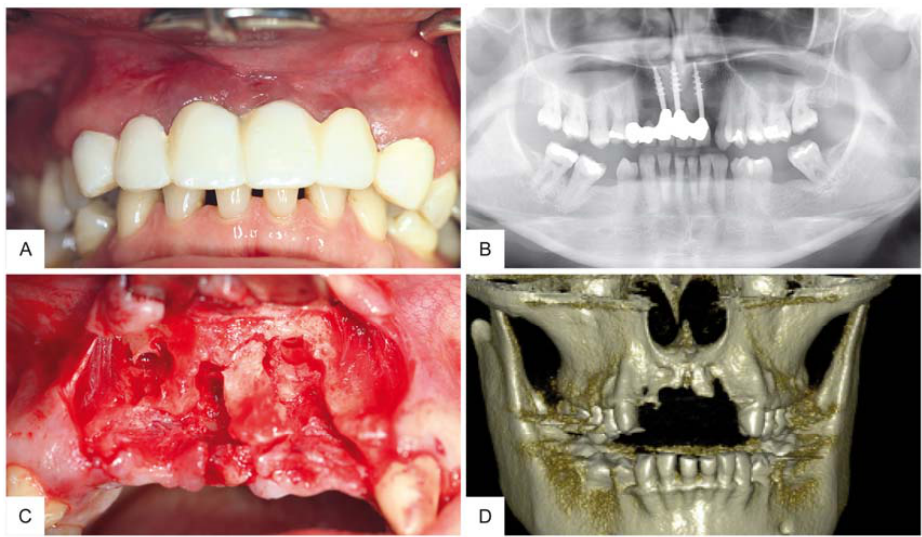
Figure 1. Clinical and radiographic examination of the maxillary defect. ( A ) Clinical preoperative examination revealed changed color in the gingiva on site #7–10; ( B ) Radiographic preoperative film partial loss of the buccal wall within the maxillary aesthetic zone after extraction of failing implants. ( D ) CBCT image of the maxillary defect after implant extraction.